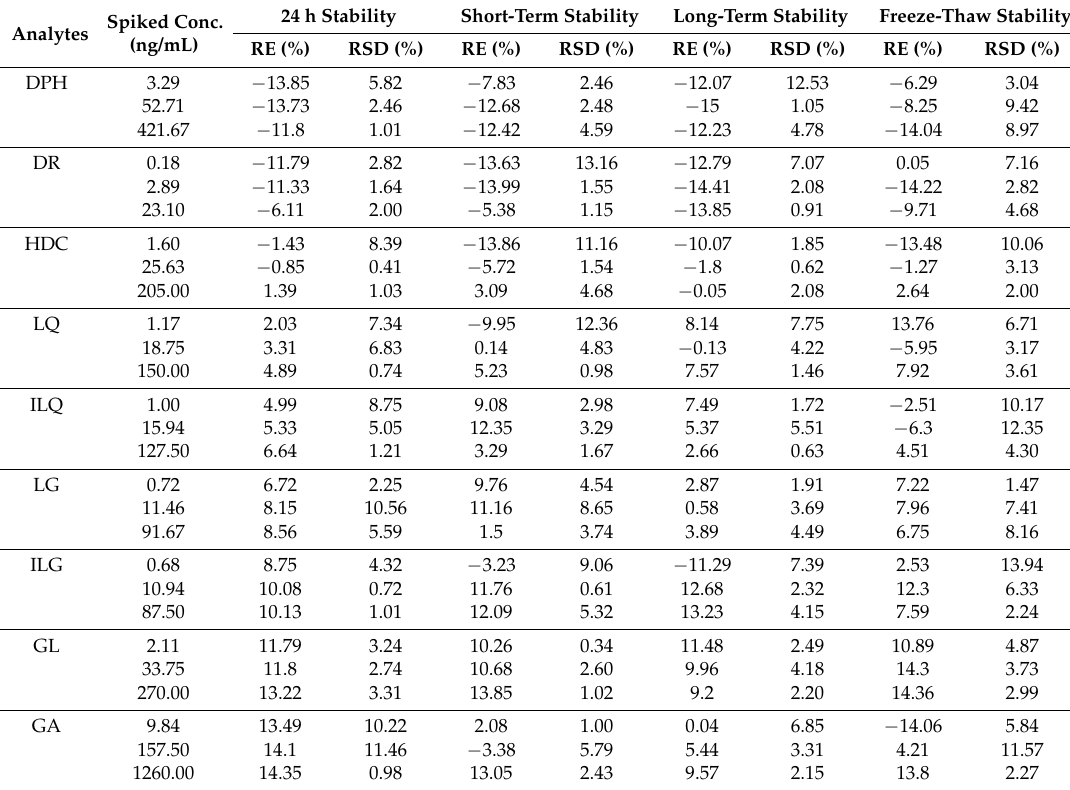
Table 4. The stability test of DPH, DR, HDC, LQ, ILQ, LG, ILG, GL, and GA in rat plasma. Spiked Conc. Analytes